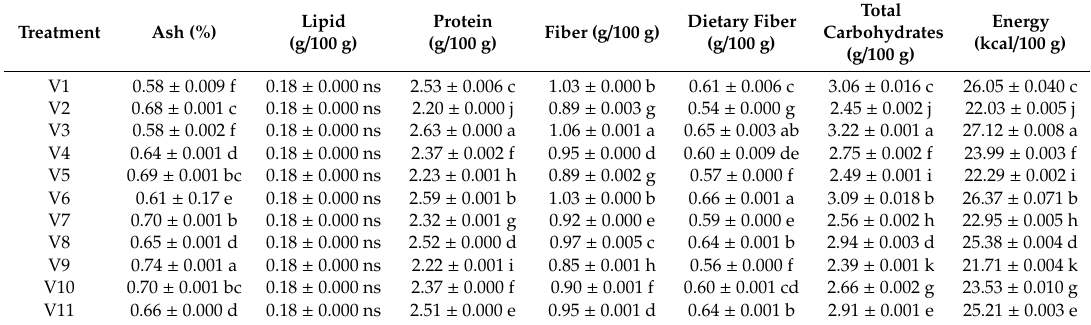
Table 2. Nutritional values of tomato fruits cv. Brillante F1 treated with different major elements (MaEs).